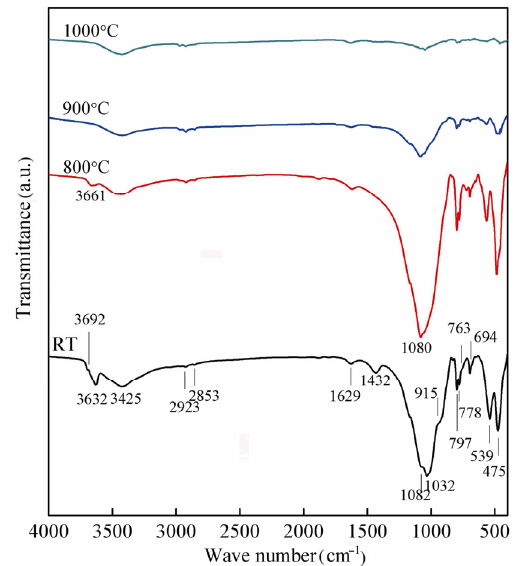
Fig. 5 FT-IR spectra of the coal gangue microspheres before and after high temperature treatment.